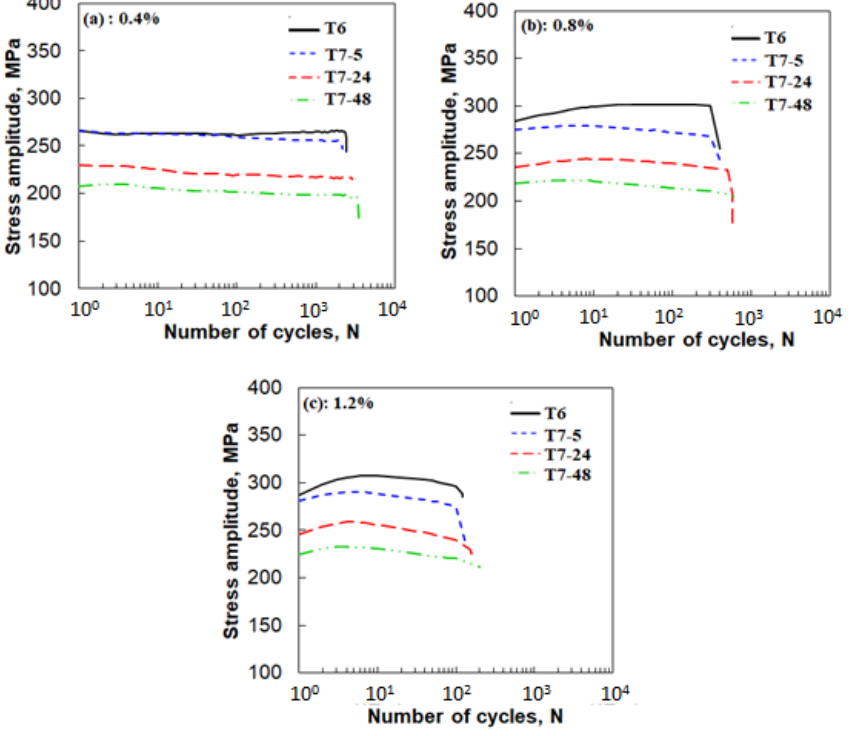
Figure 7. Stress amplitude vs. the number of cycles under various aging conditions tested at various strain amplitudes of ( a ) 0.4%, ( b ) 0.8%, and ( c ) 1.2%.